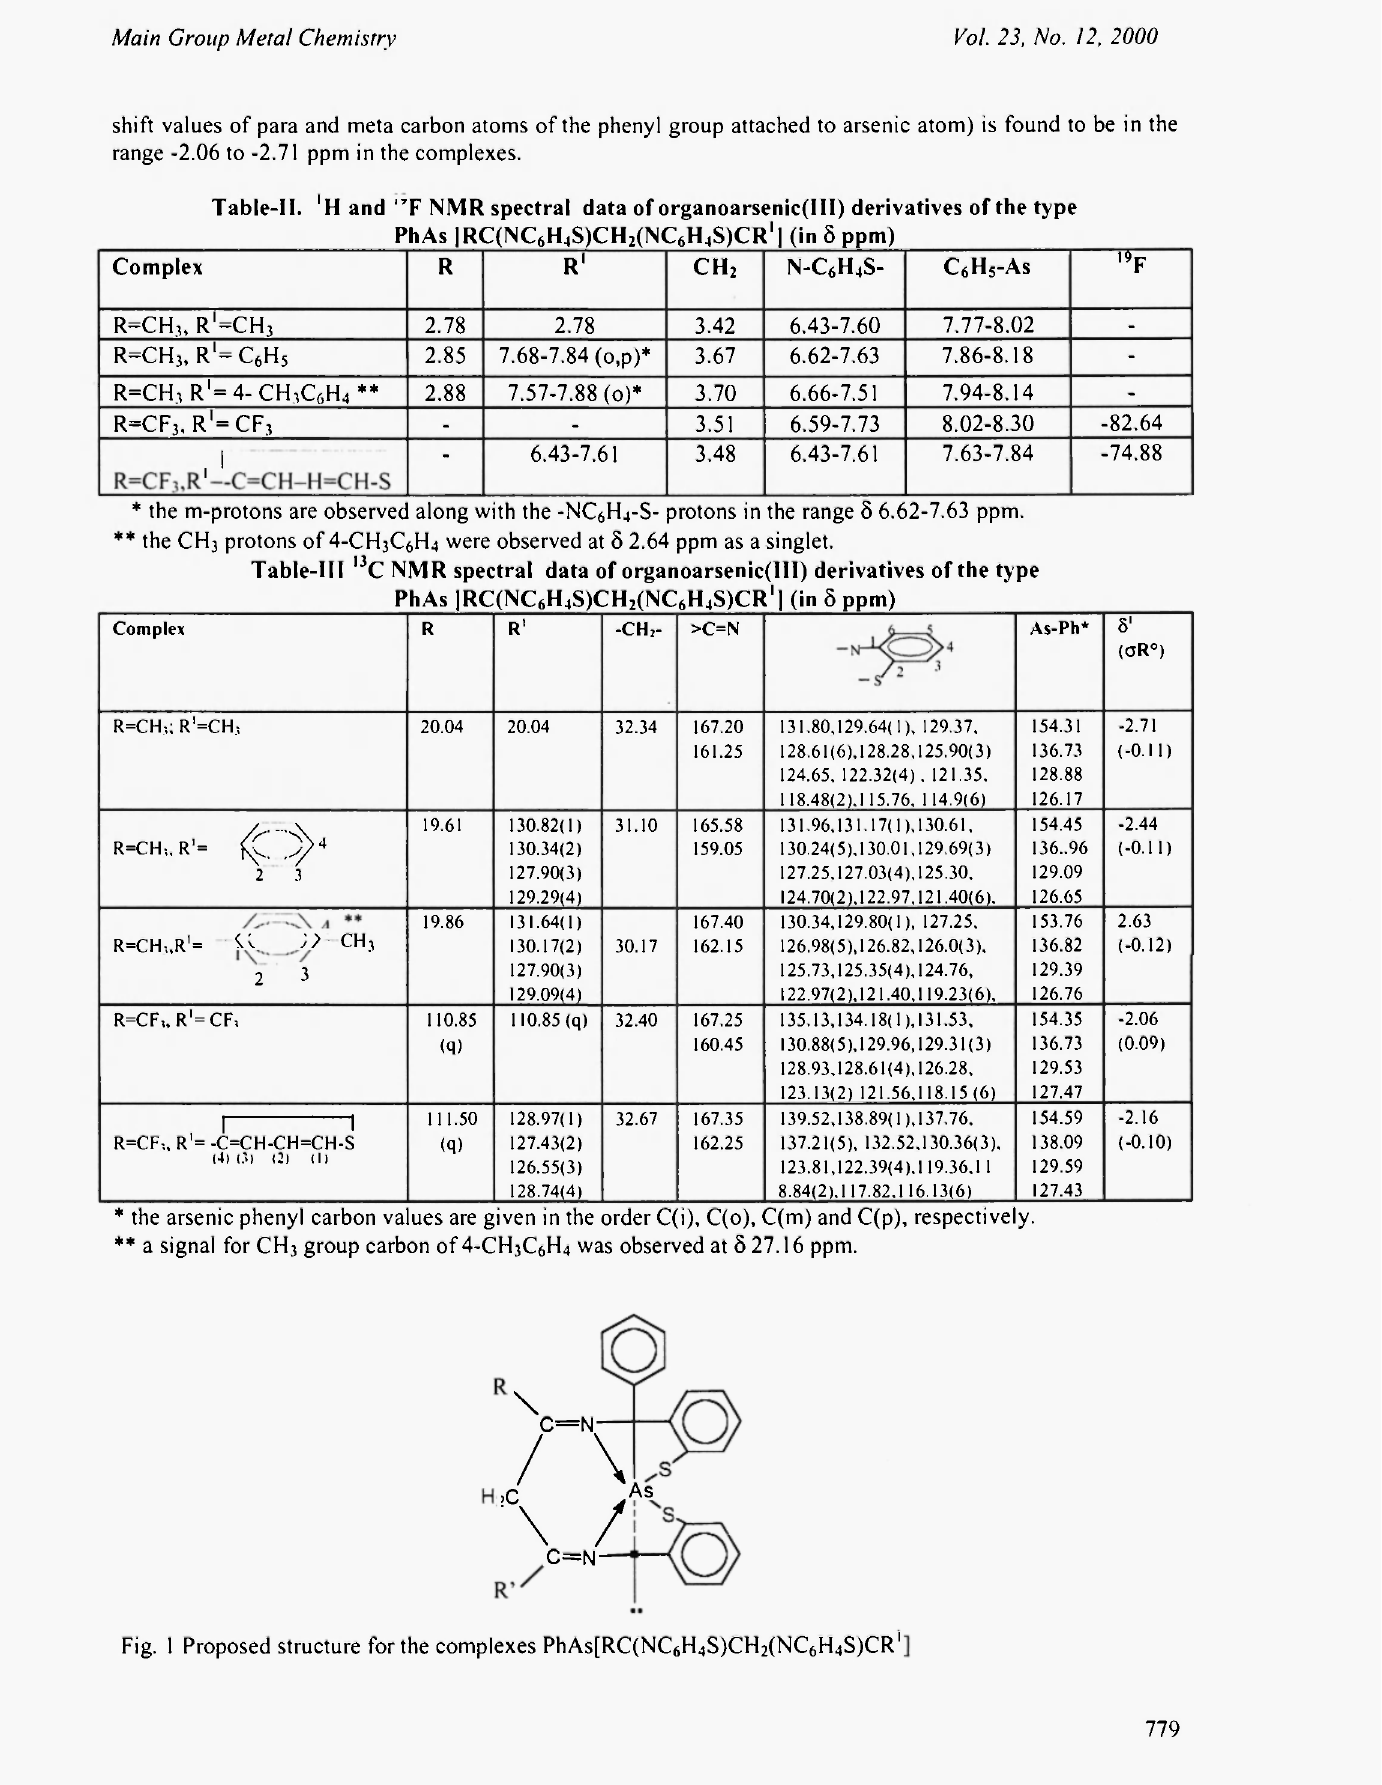
Fig. 1 Proposed structure for the complexes PhAs[RC(NC 6 H 4 S )CH2 (NC 6 H 4 S)CR